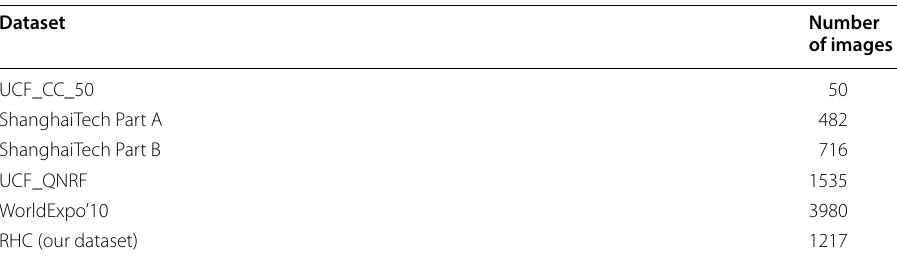
Table 2 Comparison of datasets